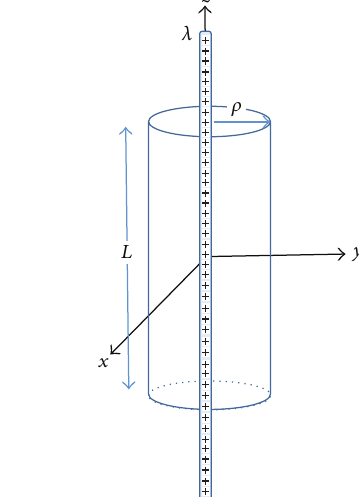
Figure 1: The Gaussian surface for an infinite charged line. The cylindrical symmetry of the problem implies that E ( x ) = 𝐸 𝜌 (𝜌)̂ e 𝜌 , where ̂ e 𝜌 is the radial unit vector in cylindrical coordinates (𝜌, 𝜑,𝑧)